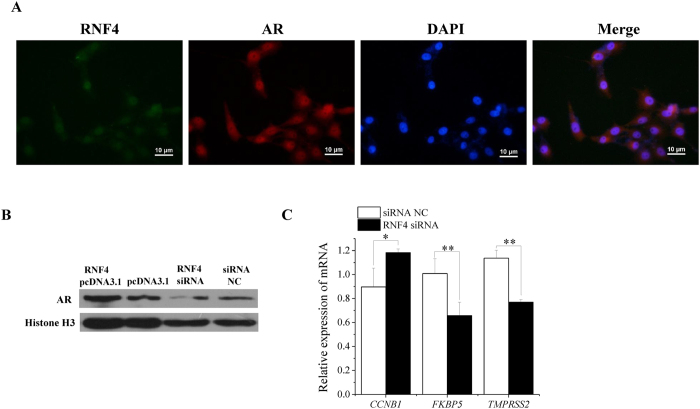
RNF4 increases AR protein in ST cell nuclei and regulates AR transcriptional regulatory activity.(A) Immunofluorescence was applied to verify the protein-protein interaction between RNF4 and AR, and the ST cells were immunostained by anti-RNF4 (green) and anti-AR (red) antibody. Cell nuclei were positive for DAPI (blue). Scale bar = 10 μm. (B) AR protein levels were detected 48 h after transfection with RNF4 pcDNA3.1 or pcDNA3.1 and RNF4 siRNA or siRNA NC in ST cells. (C) The mRNA expression levels of CCNB1, FKBP5 and TMPRSS2 were detected 24 h after transfection with RNF4 siRNA or siRNA NC. **P < 0.01, *P < 0.05.